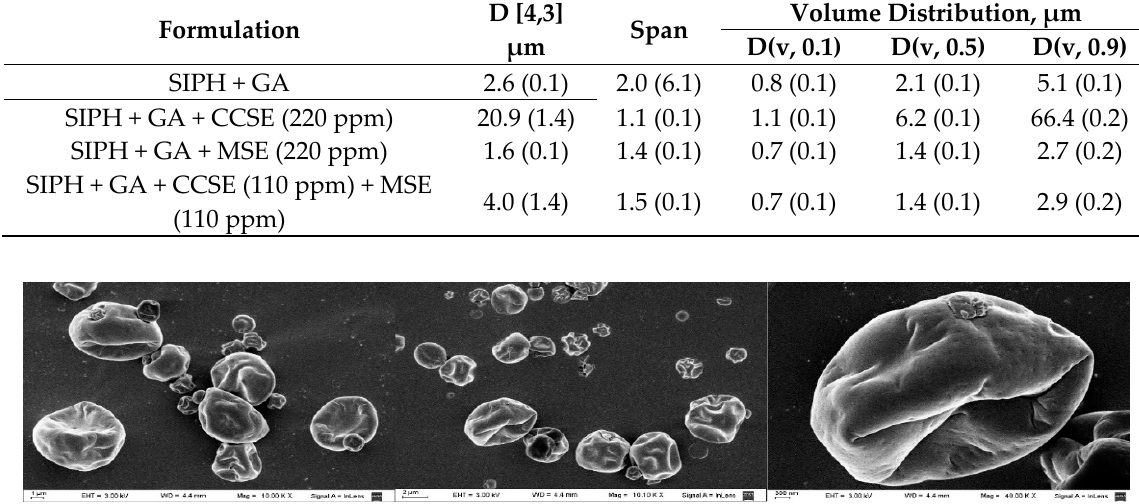
Figure 2. Morphology of microcapsule: SIPH + GA + CCSE (110 ppm) + MSE (110